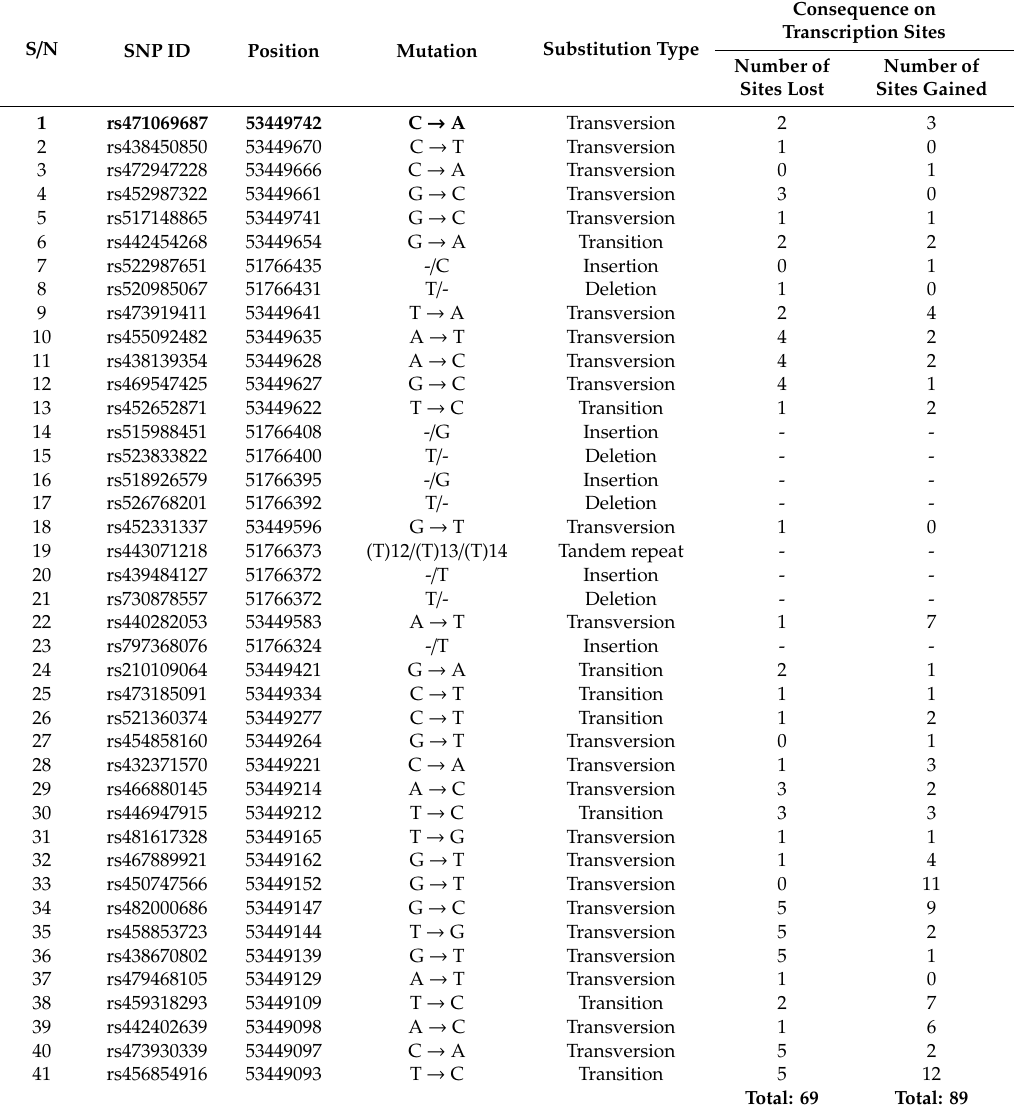
Table 1. Common single nucleotide polymorphisms (SNPs) information at the CD14 gene promoter region between N’Dama and White Fulani